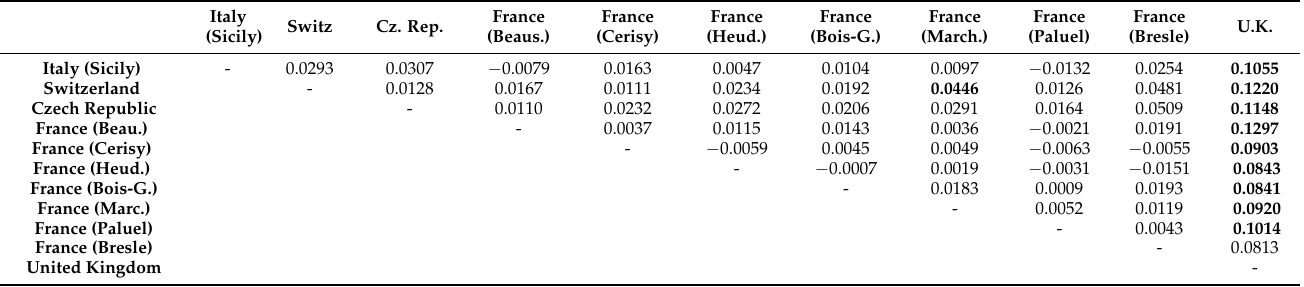
Table 3. F ST -values between all populations. Bolded values indicate a bootstrapped 95% confidence interval that does not overlap zero. The mean F ST -value is 0.0306 ± 0.0051.